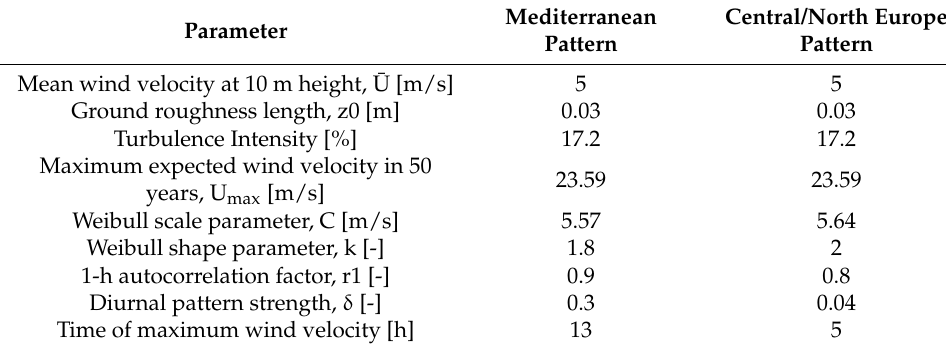
Table 3. Examined wind potential characteristics.